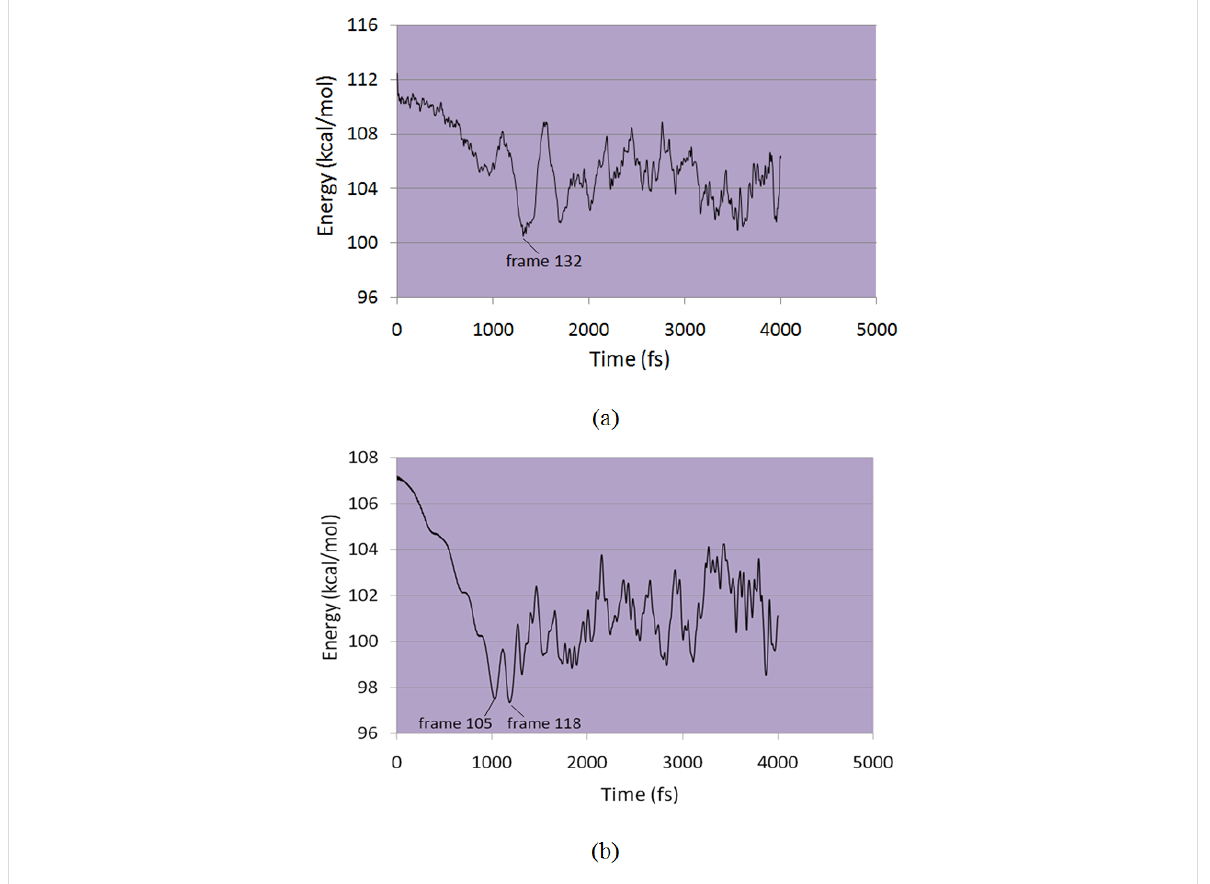
Figure 7: The time evolution of the potential energy calculated from the MD run in vacuum from (a) wide side and (b) narrow side of β -CD cavity.